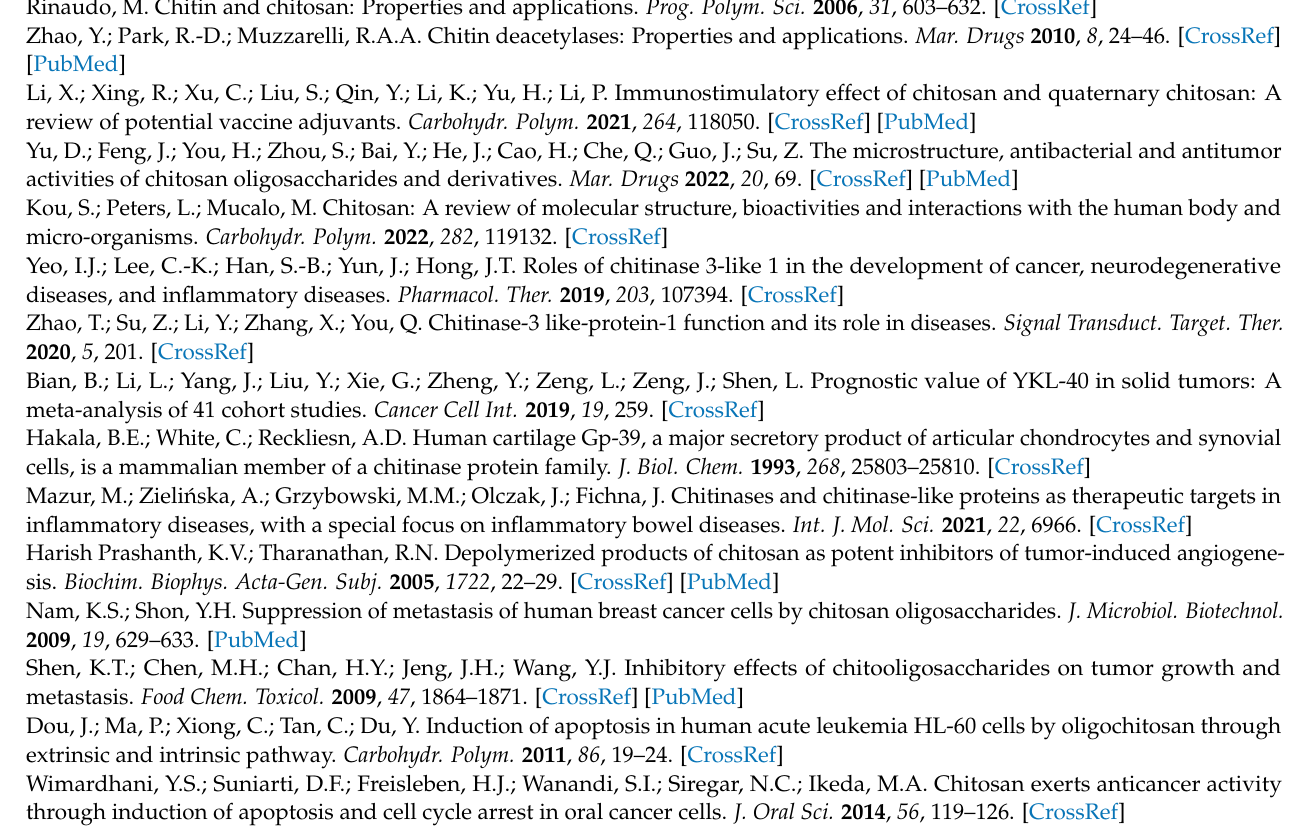
syngeneic mouse cancer models; Figure S4: Cell composition in LL2 tumors treated with COS, ICI, or ICI + COS; Figure S5: Monotherapy with COS in the MC38 colon cancer